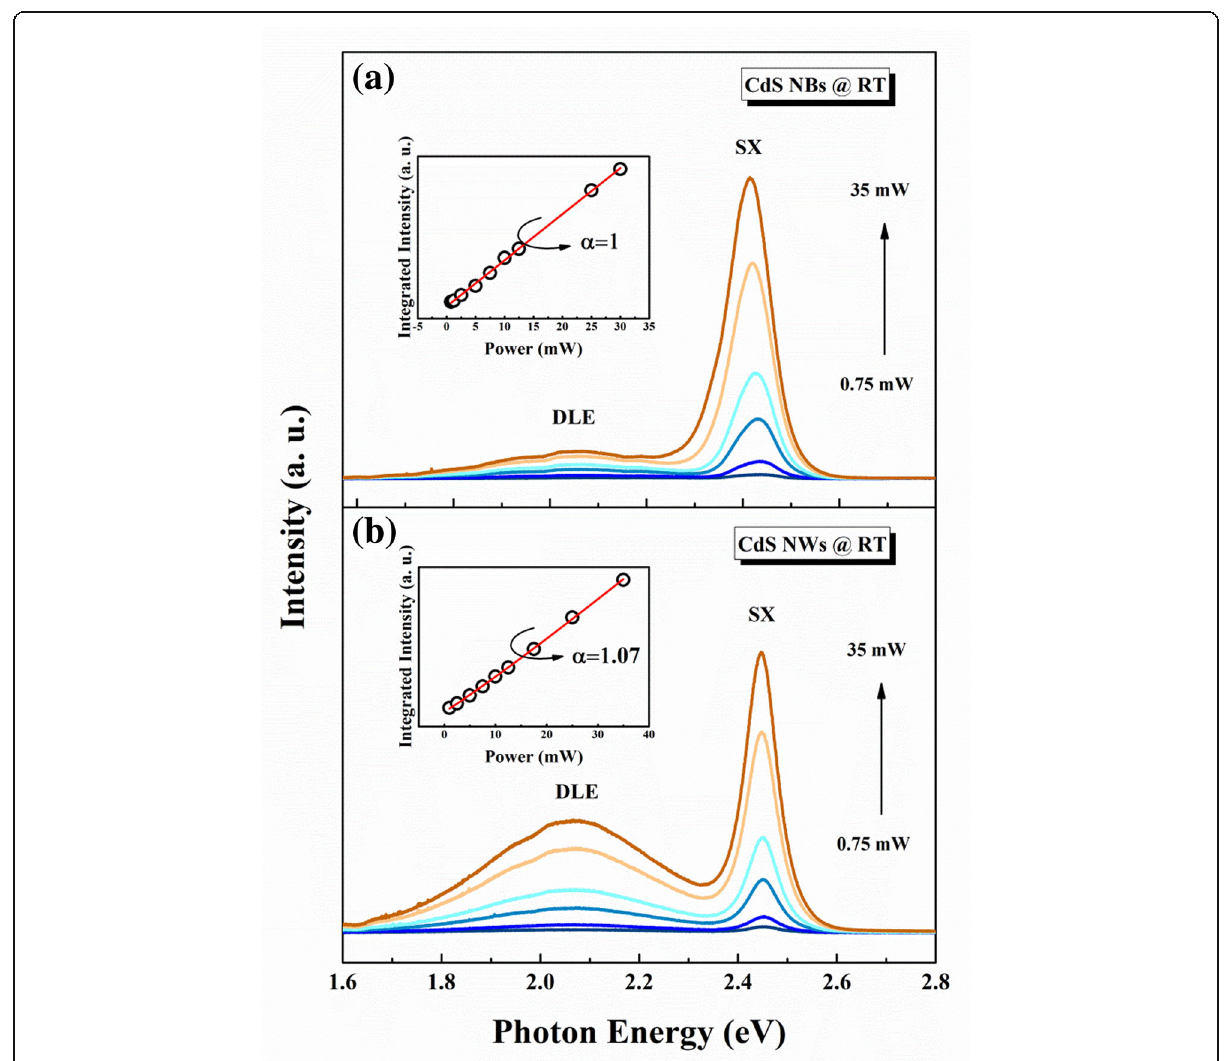
Fig. 3 a PL spectra of CdS NBs under different excitation power at room temperature, the inset is the integrated intensities of SX with the excitation power. b PL spectra of CdS NWs under different excitation power at room temperature, the inset is the integrated intensities of SX with the excitation